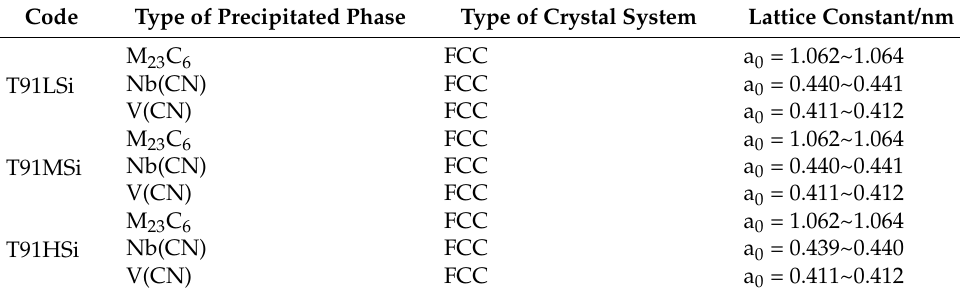
Table 2. Analysis of three experimental steel phase structures.